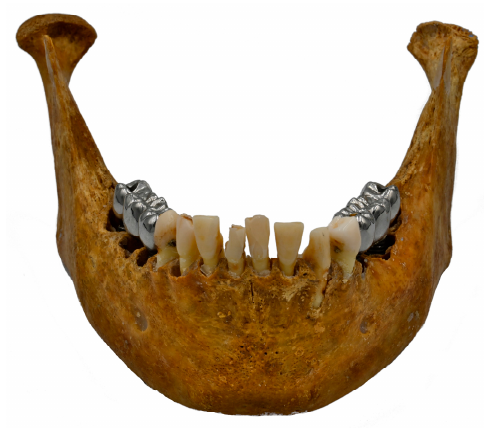
Figure 1. Partial dentate dry mandible containing a three-unit Co-Cr dental prosthesis supported by two titanium dental implants in each semi-arch. Table 1. Specifications of dental materials used in this study.